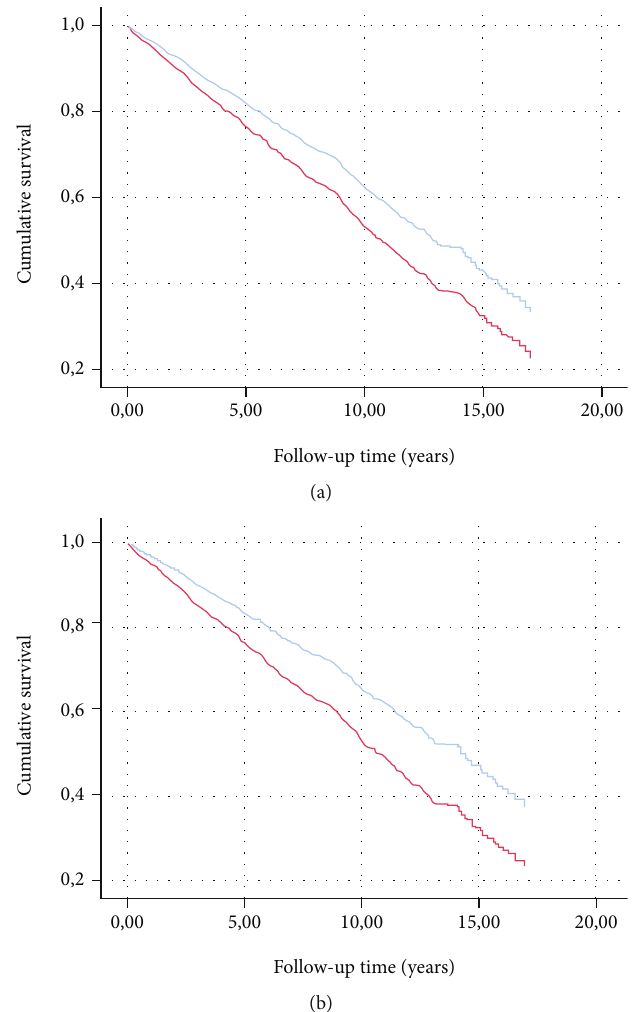
Figure 3: Cumulative survival by CAN (a) and DSPN (b) status in type 2 diabetes patients. Cox proportional hazard model adjusted for age, sex, height, BMI, current smoking, level of alcohol consumption, diabetes duration, known hypertension, systolic and diastolic blood pressure, medications, and burden of comorbidities. Curves are fi tted for populations with covariates fi xed to the population means. Presence of DSPN/CAN at baseline — red line. Absence of DSPN/CAN at baseline — blue line. DSPN: distal symmetric polyneuropathy; CAN: cardiovascular autonomic